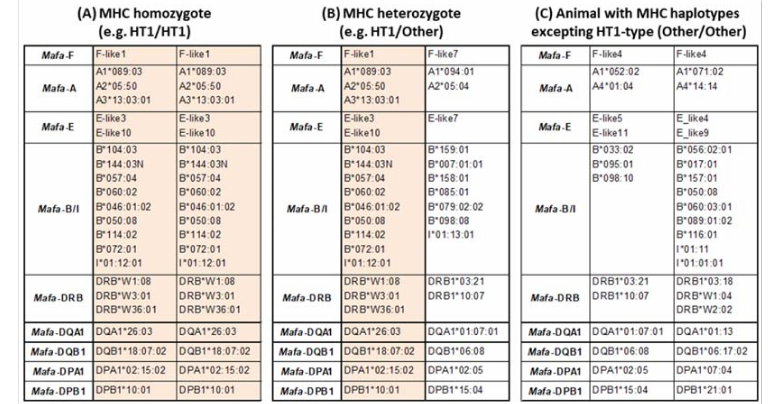
Figure 3. Examples of useful animals for non-clinical transplantation studies. Colored background shows MHC haplotype composition of HT1-type. ( A ) genotype of an HT1 homozygous animal, ( B ) genotype of an HT1 heterozygous animal ( C ) genotype of a heterozygous animal which has two haplotypes di ff ering form